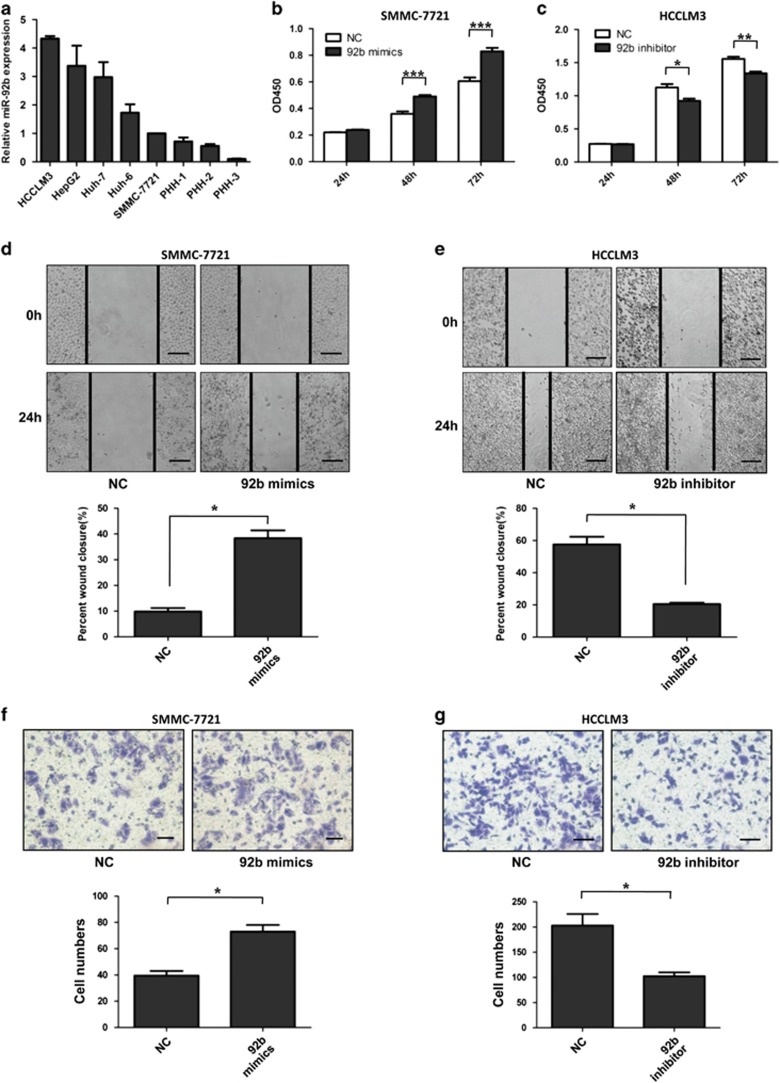
Effects of miR-92b on HCC cell proliferation and metastasis in vitro. (a) The relative miR-92b expression in five HCC cell lines (SMMC-7721, Huh-6, Huh-7, HepG2 and HCCLM3) and three primary human hepatocytes (PHH-1, 2 and 3) were determined with qRT-PCR. The data were normalized to the expression level of miR-92b in SMMC-7721 cells. Results were represented as mean±S.D. (n=3). (b–g) miR-92b was overexpressed in SMMC-7721 cells while knocked down in HCCLM3 cells. CCK-8 analysis (b and c), the wound healing assays (d and e) and transwell invasion assays (f and g) were conducted. The percent of wound closure and the number of cells passed through the membrane was counted and compared in the diagrams. Scale bars represent 500 μm (d and e) and 200 μm (f and g). Results were represented as mean±S.D. (n=3). *P<0.05; **P<0.01; ***P<0.001